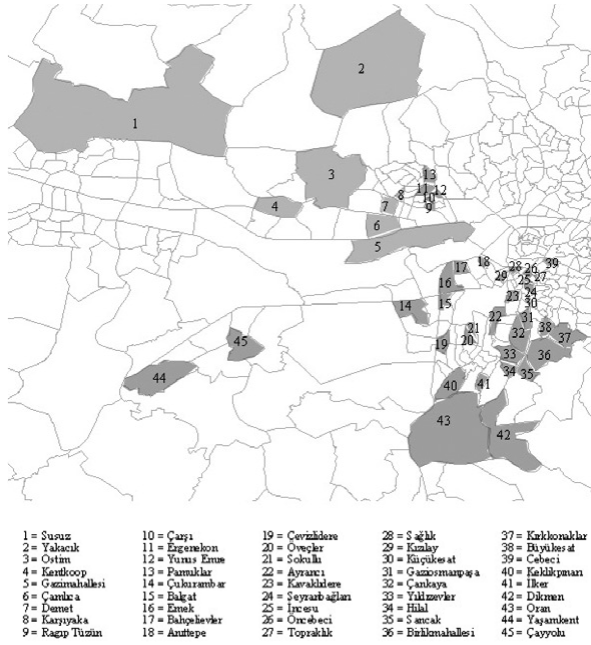
clustersFig. 1. Spatial distribution of